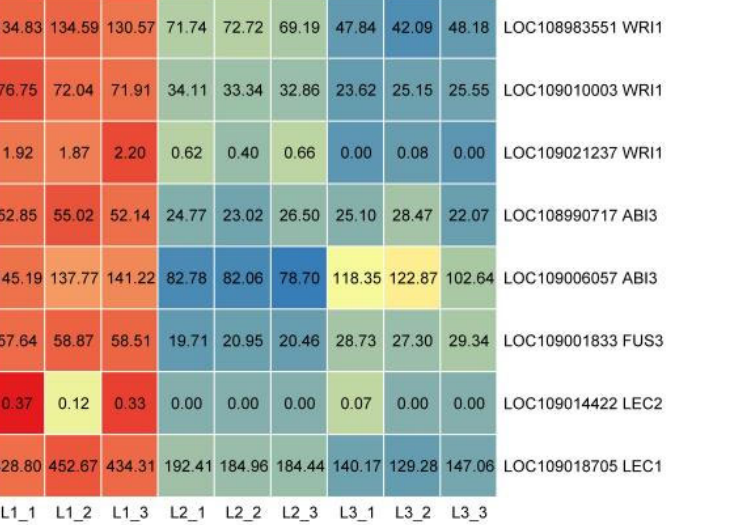
Figure 7. Expression heat map of lipid biosynthesis differential transcription factors based on FPKM. The color scale represents the calculated Z-score. Red and blue indicate higher and lower abundances, respectively. L1 was 60 DAP, L2 was 90 DAP, and L3 was 120 DAP. WRI1, ethylene-responsive transcription factor WRI1; ABI3, B3 domain-containing transcription factor ABI3; FUS3, B3 domain-containing transcription factor FUS3; LEC1, nuclear transcription factor Y subunit B − 6;